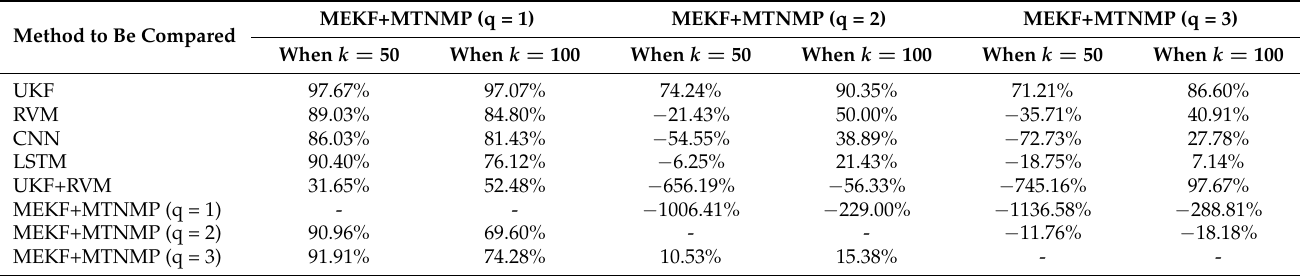
Table 3. Comparison of methods in the B0005